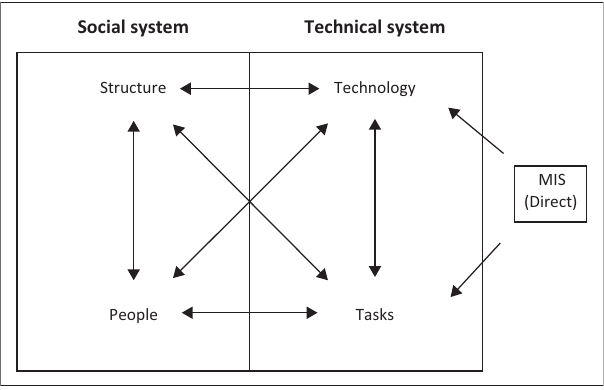
FIGURE 1: Socio-technical systems